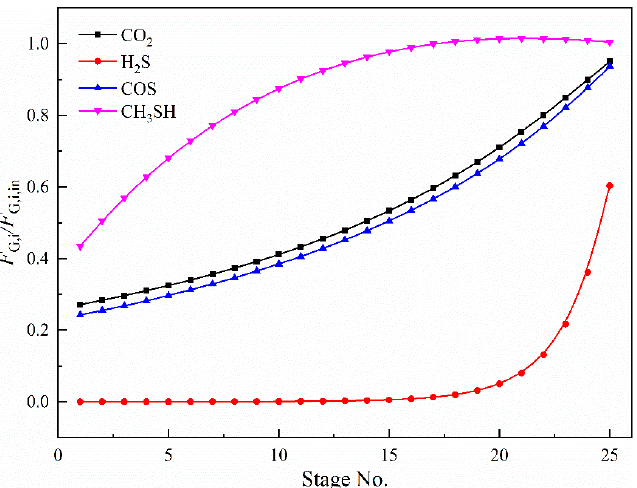
Figure 9. The concentration profile of each component in the absorption column (overflow weir height: 0.15 m; absorption pressure: 6 MPa; inlet gas flow rate: 5.0 × 10 6 Nm 3 /d; inlet gas–liquid ratio: 600; inlet gas loading: CO 2 , 4.5 vol.%; H 2 S, 1.5 vol.%; COS, 15 mg/m 3 ; and CH 3 SH, 15 mg/m 3 ).